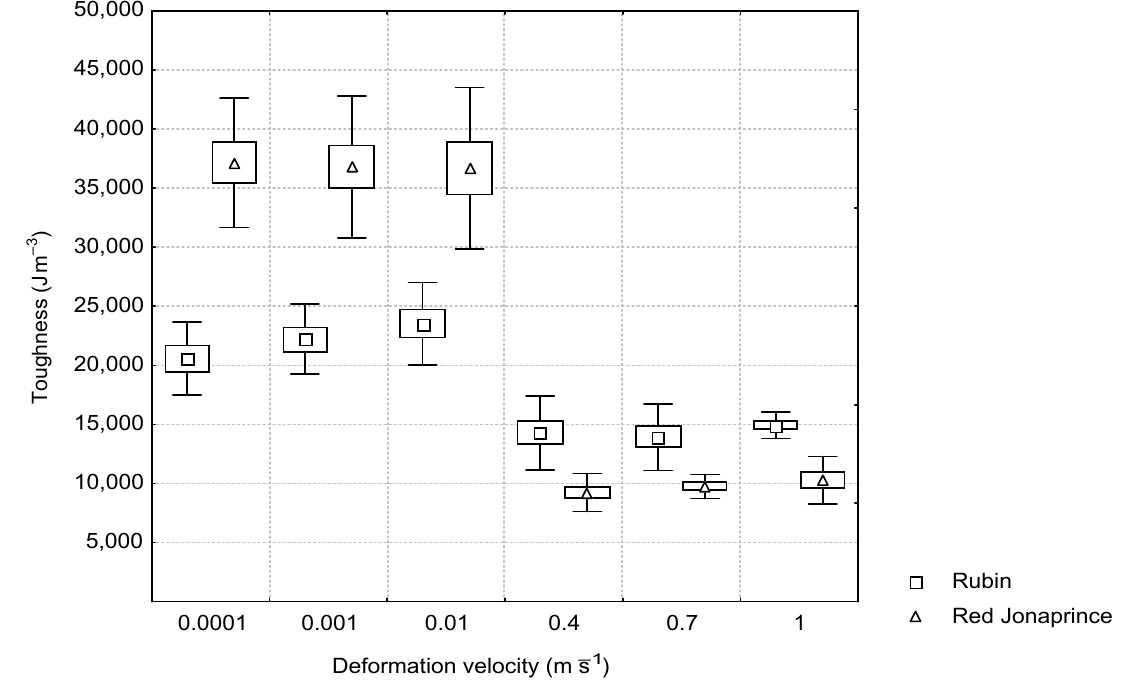
Figure 5. Relationship between the toughness and the deformation velocity for the two apple culti- vars.